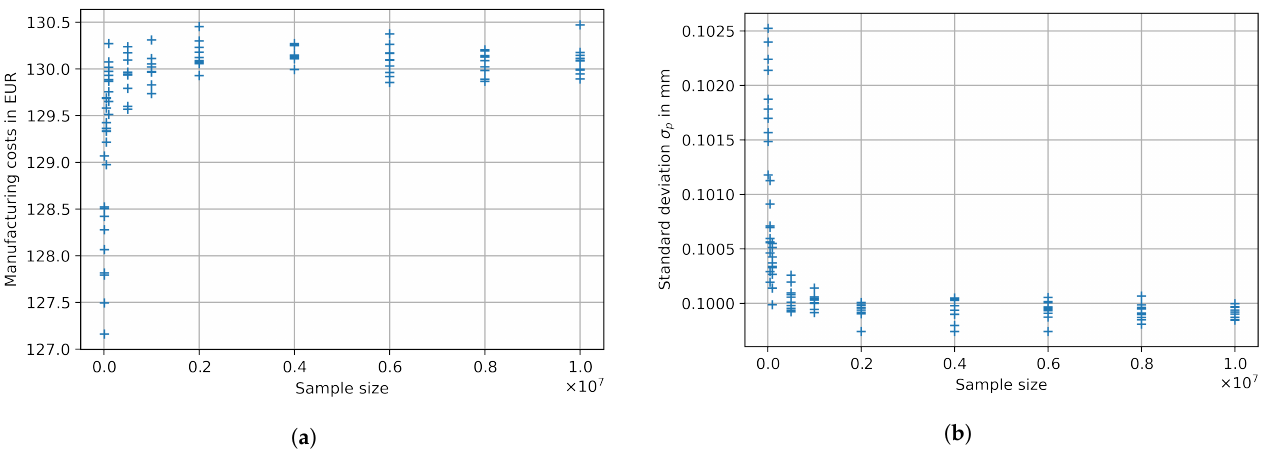
Figure 9. Statistical tolerance synthesis using GPU (CuPy Float 32 F-Order): ( a ) Manufacturing costs vs. sample size for 10 runs, and ( b ) standard deviation σ p (calculated with 1.0 × 10 7 sample size) vs. sample